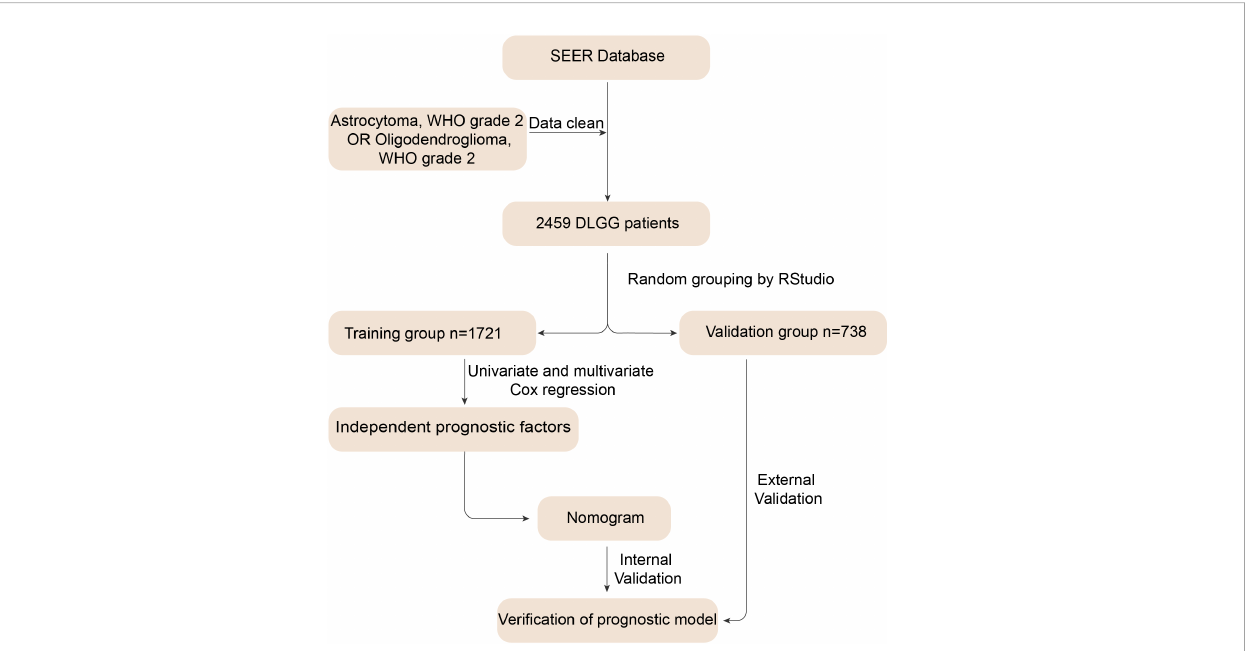
FIGURE 1 Flow chart for constructing the nomogram. First, we identi fi ed 2459 patients diagnosed with astrocytoma and oligodendroglioma and removed invalid information. Then, we randomly divided the data into training and validation groups. The training group data were used to derive independent prognostic factors and construct a nomogram. Finally, we performed internal and external validation to verify the predictive value of the nomogram.